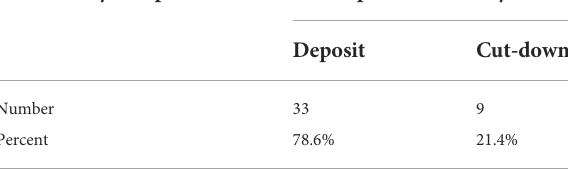
TABLE 1 The development tendency of debris fl ow disaster lands of Fujiang River